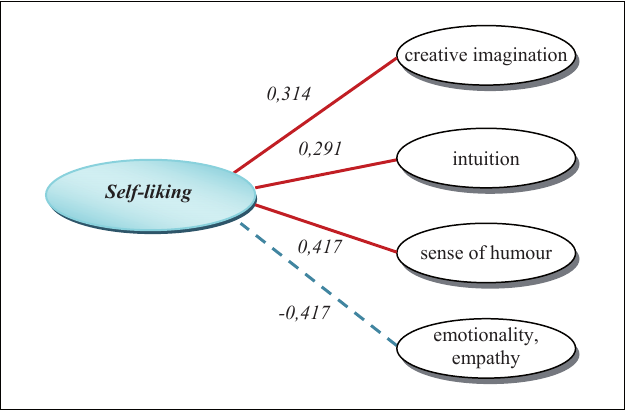
Fig. 8. Correlation of self-liking with creativity